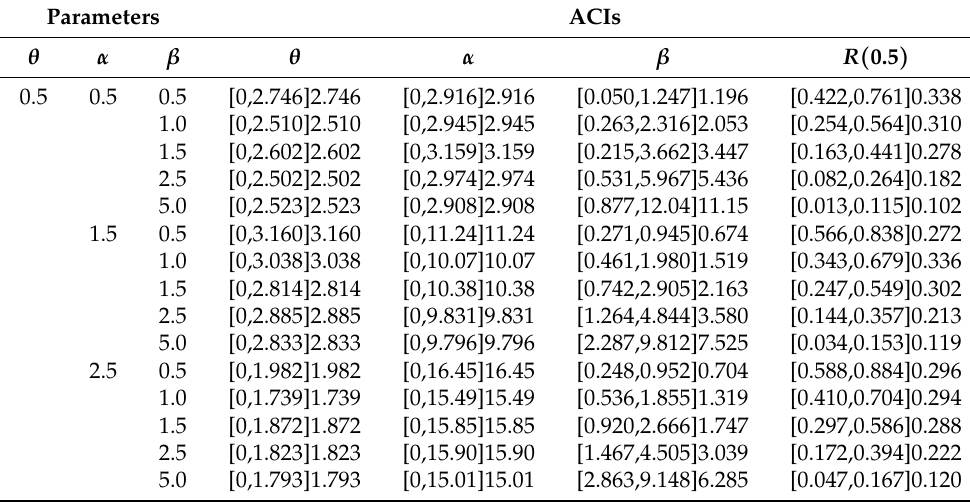
Table 4. The AVs of CIBs (in parentheses) and the corresponding CILs for n = 25.